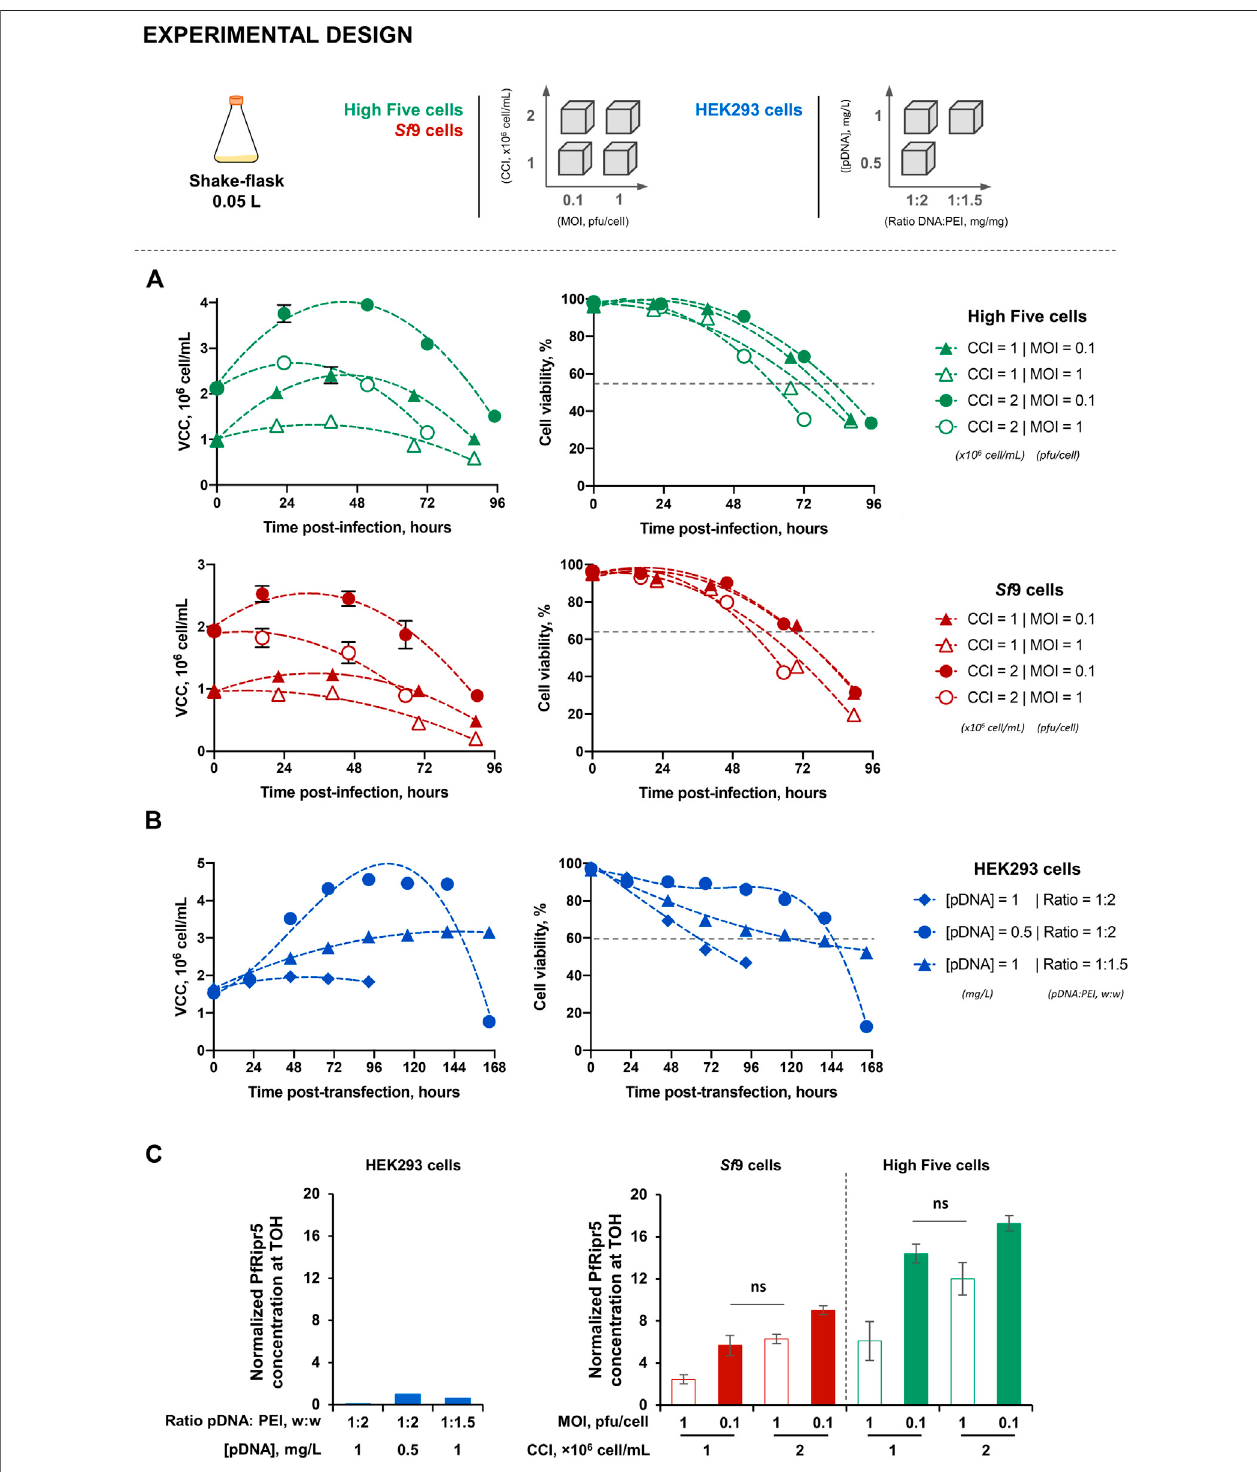
FIGURE 2 | Production of the PfRipr5 recombinant protein. (A) Kinetics of cell growth and viability upon infection of insect High Five (green) and Sf 9 (orange) cells at differentcombinationsofcellconcentrationatinfection(CCI)andmultiplicityofinfection(MOI). (B) KineticsofcellgrowthandviabilityupontransfectionofhumanHEK293cellsat differentcombinationsofthePfRipr5plasSmid DNA(pDNA)concentration(pDNA)andratiopDNA:PEI. (C) RelativePfRipr5concentrationatthetime-of-harvest(TOH)ofeach production condition. Data are expressed as mean ± standard deviation. For insect cells, data are relative to three biological replicates( n = 3). For human cells, data are relative to one biological replicate ( n = 1). For fi gure (A,B) , VCC denotes viable cell concentration. For fi gure (C) , relative PfRipr5 expression was assessed by a densitometry analysisofwesternblot( SupplementaryFigureS1 )asdescribedintheM&Msection;graphisnormalizedat1forthebestconditionusinghumancells[i.e.,(pDNA)=0.5 mg/L and ratio pDNA:PEI = 1:2